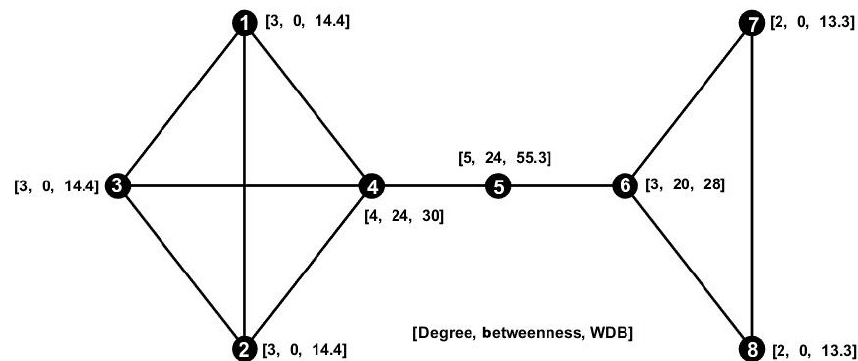
Figure 2. The synthetic network to explain the degree (k) , betweenness centrality (B) , and weighted degree–betweenness (WDB) measures, showing the node number (1 to 8) followed by the degree, betweenness centrality value, and WDB values in brackets [ k,B , WDB]. The degree and betweenness are limited with respect to distinguishing the role of different nodes in the network and centers from bridges, respectively.